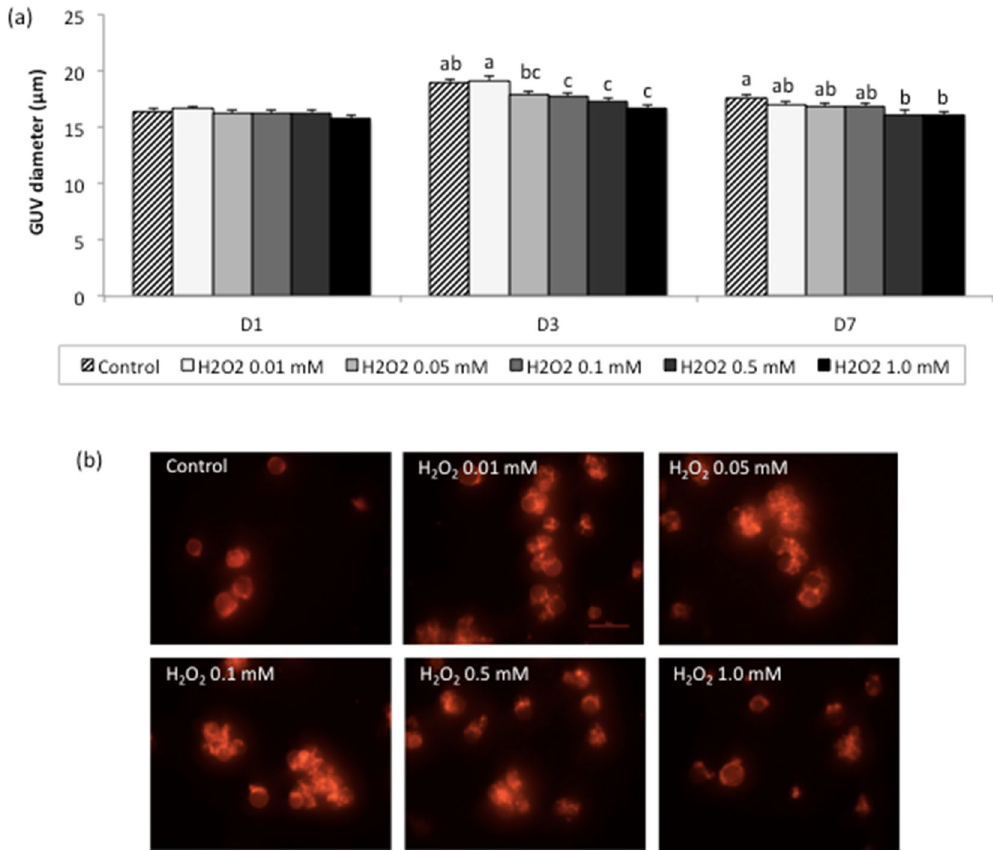
Figure 2. Diameter of giant unilamellar vesicles (GUVs) cultured in vitro with different concentrations of hydrogen peroxide (H 2 O 2 ). ( a ) Data are expressed as the mean ± standard error of three independent replicates (control, n = 1,031; H 2 O 2 0.01 mM, n = 891; H 2 O 2 0.05 mM, n = 882; H 2 O 2 0.1 mM, n = 786; H 2 O 2 0.5 mM, n = 907; and H ( P < 0.05). ( b ) Representative photomicrographs of GUVs collected from culture wells on D7 of the different treatments. ×40